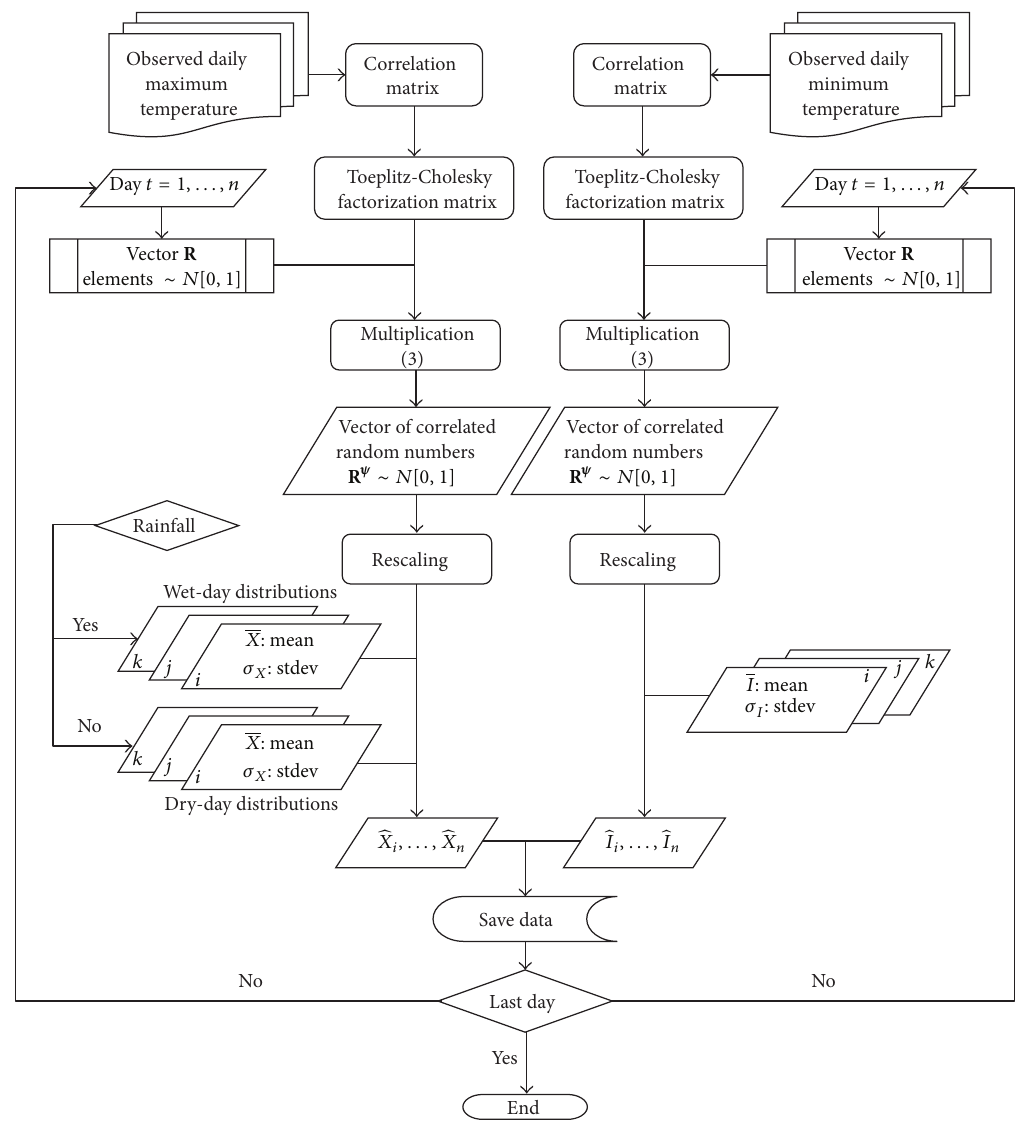
Figure 1: Flow diagram detailing the sequence of processes to generate maximum and minimum temperatures following the first model.